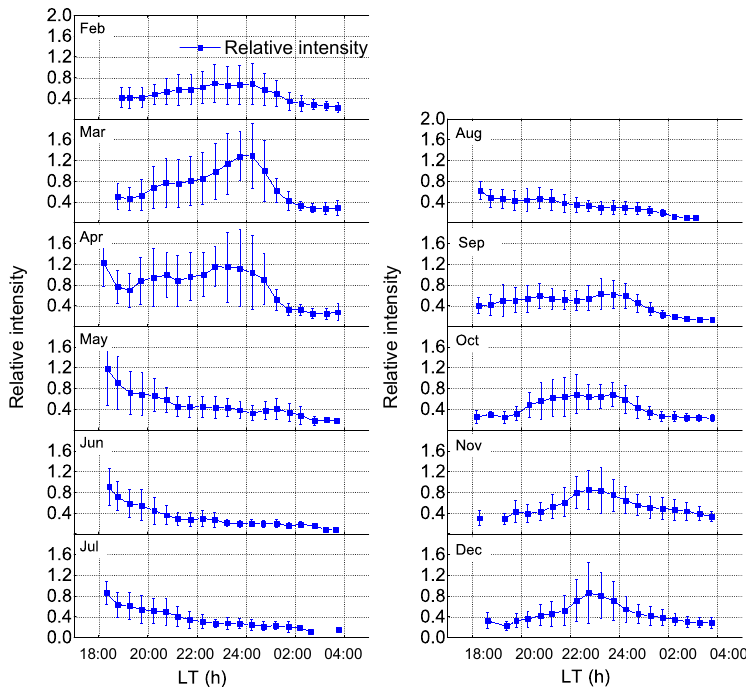
Figure 7. Monthly average of the OI630nm relative intensity. LT is UT − 3.